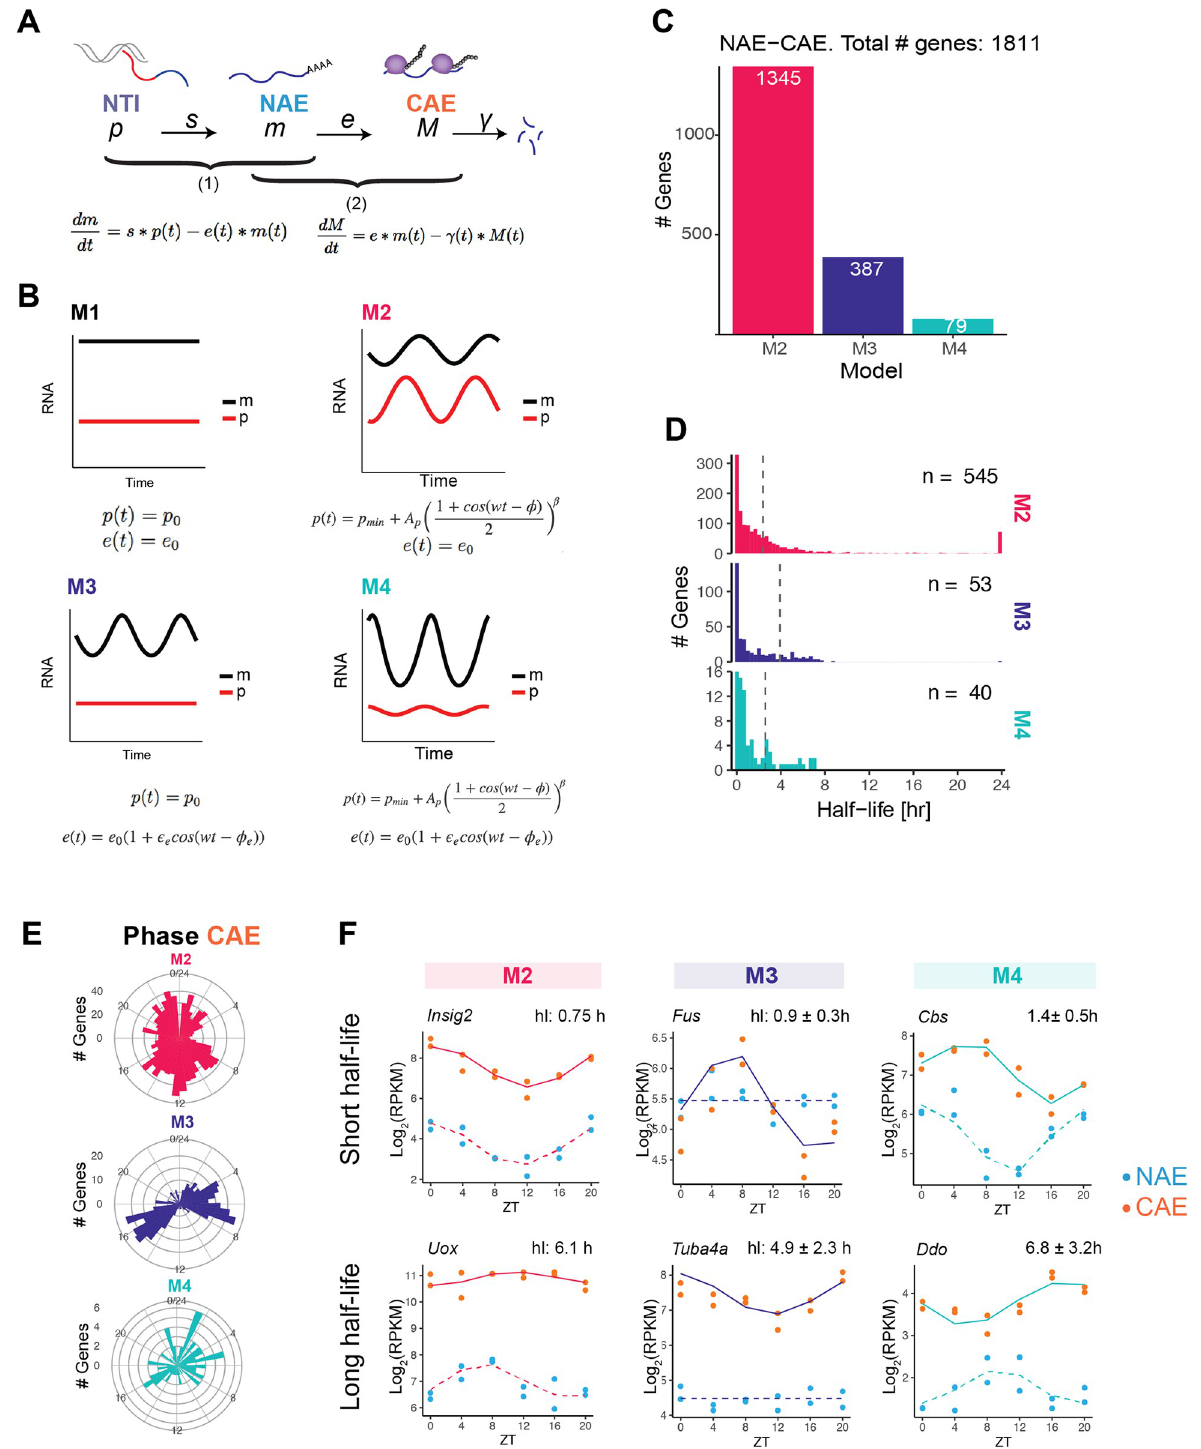
Fig 4. Model-based identification of regulatory steps driving rhythmic cytoplasmic mRNA profiles. A : Kinetic model describing the temporal accumulation of pre-mRNA and mRNA. RNA processing steps are split in two steps: first, we describe the temporal accumulation of nuclear mRNA (NAE) in function of splicing rate s and export rate e (step 1), and second, the temporal accumulation of cytoplasmic mRNA (CAE) in function of export rate e and degradation rate γ (step 2). B : The combination of constant or rhythmic pre-mRNA ( p ) and constant or rhythmic export in step 1 generates four models. Rhythmic pre-mRNA profile is described by a cosine function with a period of 24 hours, raised to a power β to account for